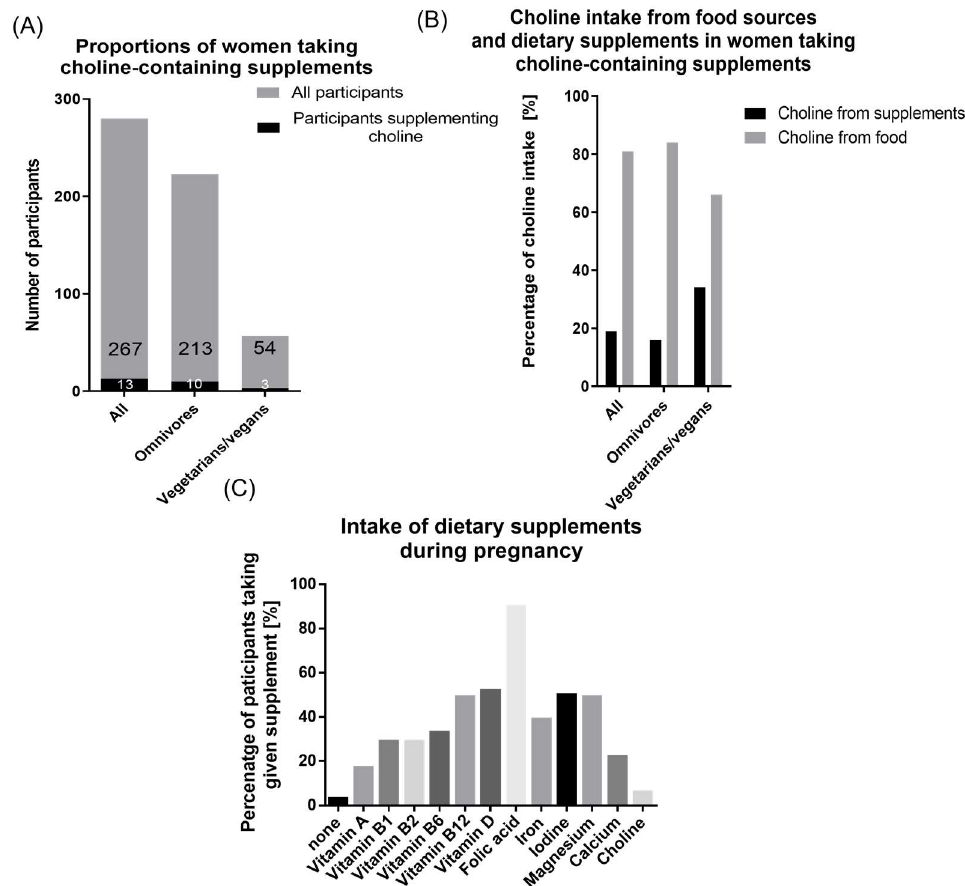
Figure 3. Intake of dietary supplements. ( A ) Proportion of participants taking choline-containing dietary supplements in all (13/267), omnivorous (10/213), and vegetarian/vegan (3/54) participants ( B ) Percentage of choline coming from food sources and dietary supplements in participants supplementing choline (all n = 13; omnivore n = 10, vegetarian/vegan n = 3) ( C ) Intake of dietary supplements during pregnancy. Percentage of participants taking given supplement alone or as a part of a prenatal vitamin complex supplement.